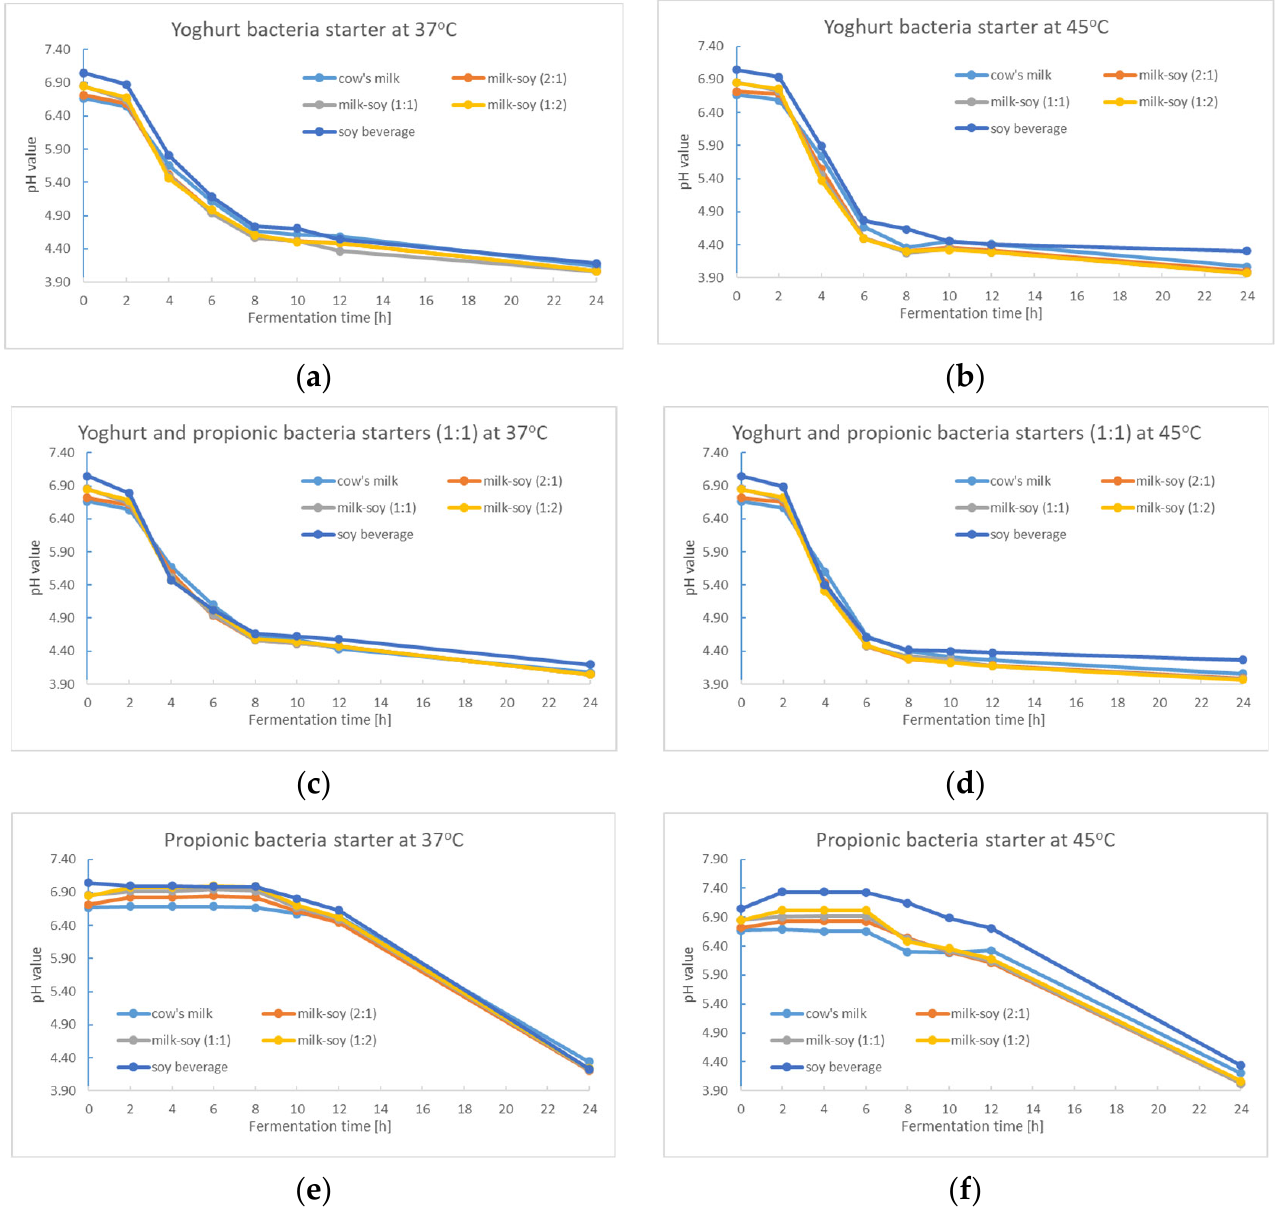
Figure 1. ( a – f ) The fermentation kinetics (mean values) of milk, milk–soya, and soya beverages with different starter cultures (yoghurt bacteria starter ( a , b ); propionic bacteria starter ( e , f ); a mixture thereof (1:1) ( c , d )) at two different fermentation temperatures (37 °C ( a , c , e ) and 45 °C ( b , d , f )).